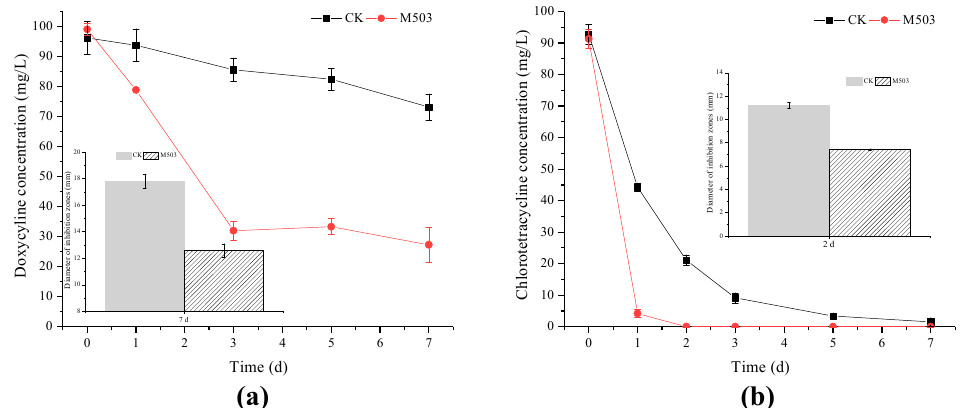
Figure 6. Doxycycline degradation curves and antibacterial potency of degradation products of two groups at seven days (bar plot) ( a ). Chlorotetracycline degradation curves and antibacterial potency of degradation products of two groups at two days (bar plot) ( b ). (M503: group with strain M503; CK: group without srain M503.) Values are expressed as mean of three replicates with standard deviations.